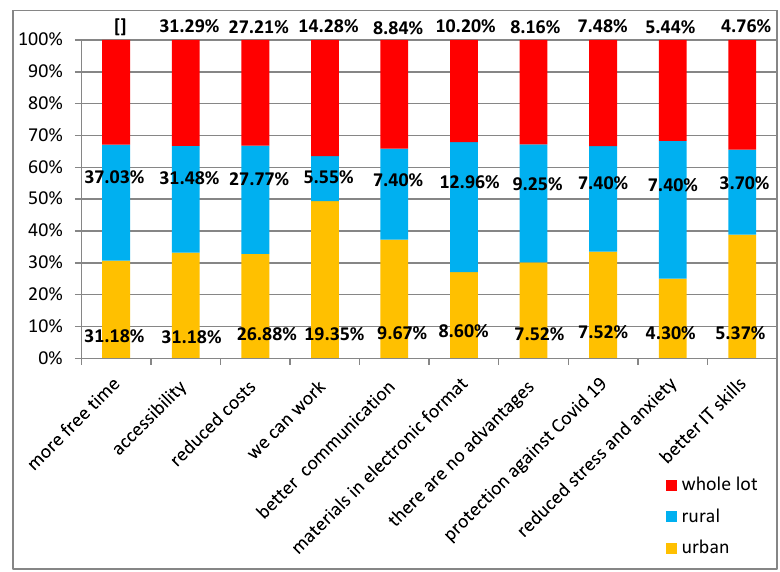
Figure 1. Graphical representation of the main advantages offered by online activities. Table 6 identifies the main shortcomings identified by the students surveyed in rela- tion to online teaching activities, separately by background and as total number, and Fig- ure 2 graphically presents the percentages of the identified common answers, also in de- scending order. Table 6. Ordering the problems generated by the online activity based on the origin environment. Nr.